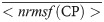
Critical states revealed through distinct functional behaviors of the bimodality coefficient: A) MCF-7 cells, B) HL-60 cells and C) Random DMSO expression matrix (see Fig 3D). The left panels (A and B) show the frequency distribution of expression according to the degree of nrmsf. The center panels show the temporal average of Sarle's bimodality coefficient, <bi>, of the ith group over time; the value 5/9 represents the threshold between the unimodal (below 5/9) and bimodal or multimodal distributions (above 5/9). The grouping of expression is made at a specific sequence of discrete values of nrmsf (xi: nrmsfi = i/100; i: integers) with a fixed range: xi—k.d < xi < xi + k.d. The values of k and d are set to be k = 150 and d = 0.0001 for MCF-7 and HL-60, and k = 100 and d = 0.001 for a random matrix based on the convergence of the bimodality coefficient. The convergence of the difference in bimodality coefficients at xi with an increase in k (i.e., as the number of elements in a group increases) is shown between the next neighbors, <bi(k;xi)>—<bi(k-1;xi)> for HL- 60 cells in the right panels of B). The 6 colored dots represent the convergent behaviors of different nrmsf points. The behavior of the time average of the bimodality coefficient exhibits A) Tangent hyperbolic function, bi = a − tanh(b + c⟨nrmsf⟩i); a = 1.38 and 1.35; b = 0.123 and 0.301; c = 13.8 and 10.2 for HRG (p< 10−4) and EGF (p< 10−10), respectively, B) Heaviside step function-like transitions for HL-60 cell fates, and C) No transition for a random DMSO expression matrix, which importantly reveals that random noises through the formation of a Gaussian distribution destroy a sandpile critical behavior. Based on these distinct behaviors, we can determine the boundaries of averaged critical states (Table 1; see section III): A) Critical states are defined by two points: the average CP, <nrmsf(CP)>¯, the onset of a genome avalanche (Fig 4A), for the upper boundary of the sub-critical state, and the point where the change in the bimodality coefficient, Δ<bi>, reaches zero for the lower boundary of the super-critical state; the near-critical state is between them, and B) Step function-like transitions reveal the boundaries of averaged critical states, where the near-critical state corresponding to the transitional region separates the other states.